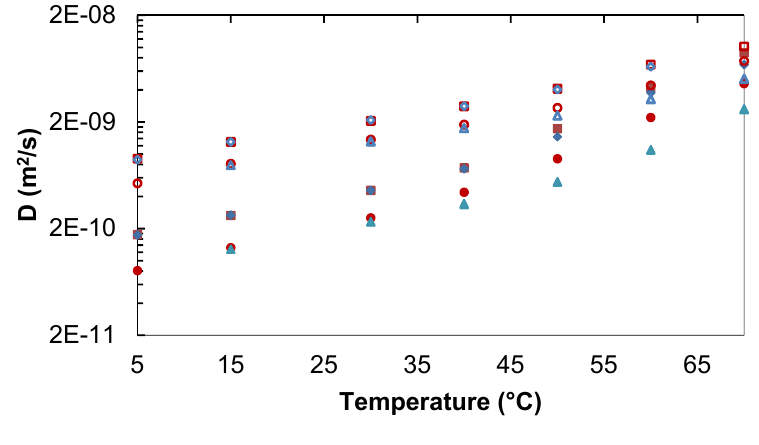
Figure 1. Diffusion of trehalose, lactose and water in trehalose/water and lactose/water solutions. Lac 34 mg/mL: ■ Lac, □ D ♦ Tre, ◊ D O. Tre 258 mg/mL: ▲ Tre, D 2